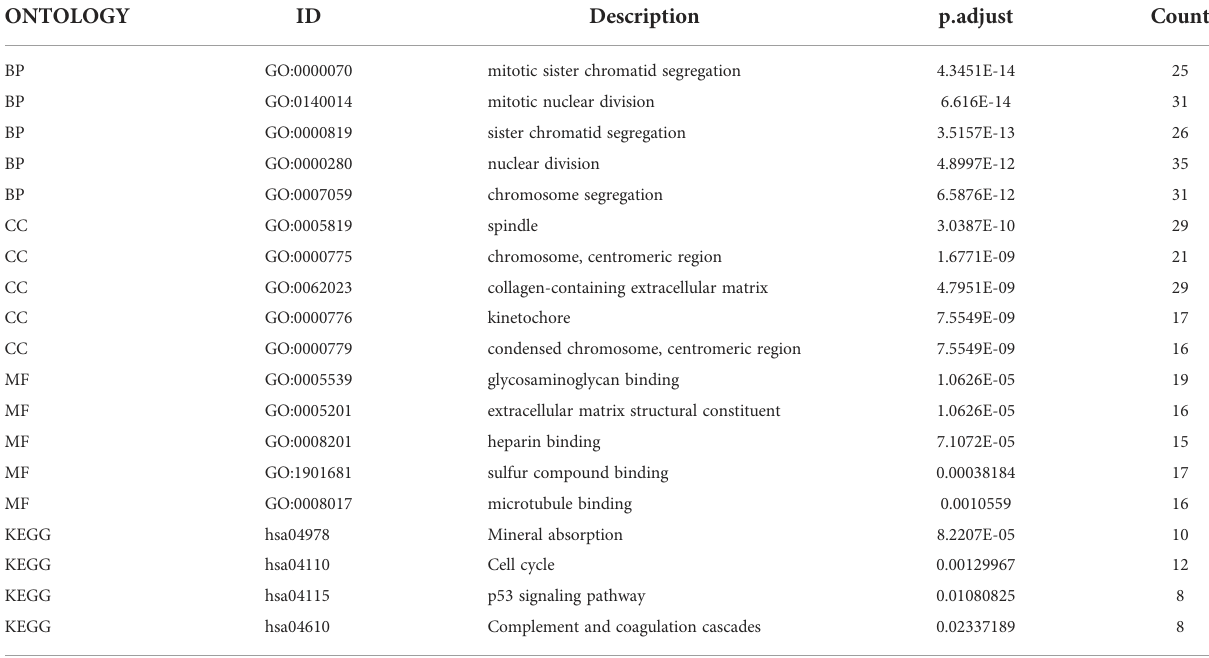
TABLE 1 Enrichment analysis results of GO and KEGG of differentially expressed immune